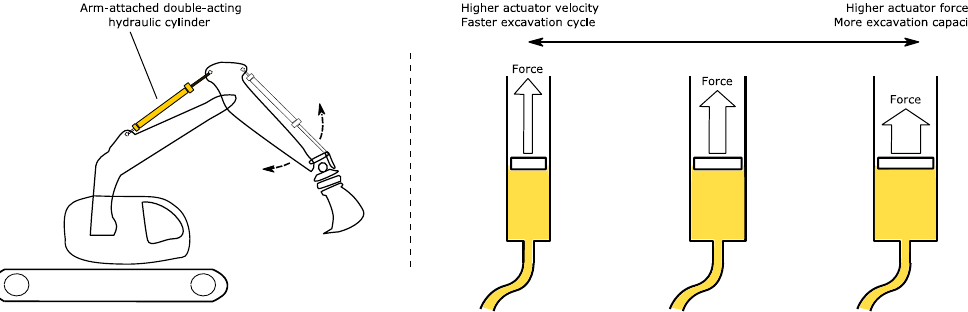
Figure 7. Schematic of decision-making considerations for the arm-attached hydraulic actuator.